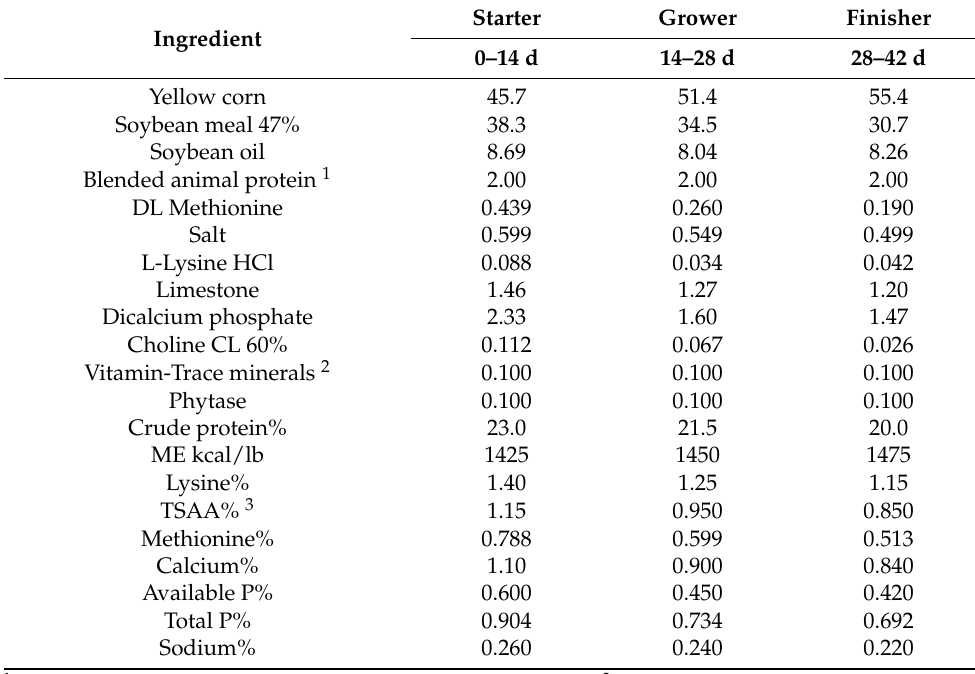
Table 1. Feed composition (%) and formulated nutrient profile of